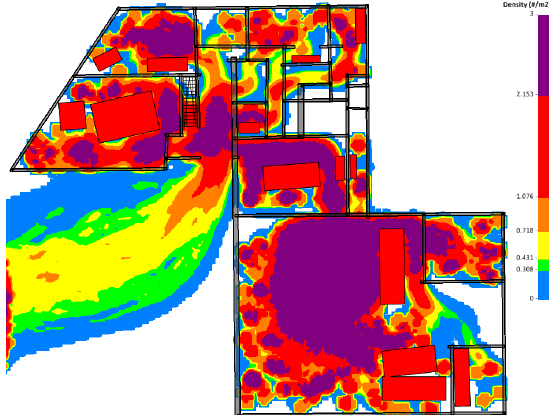
Figure 9: The result of evacuation density map. The colors are based on the number of people per square meter. The purple areas are dense area during the